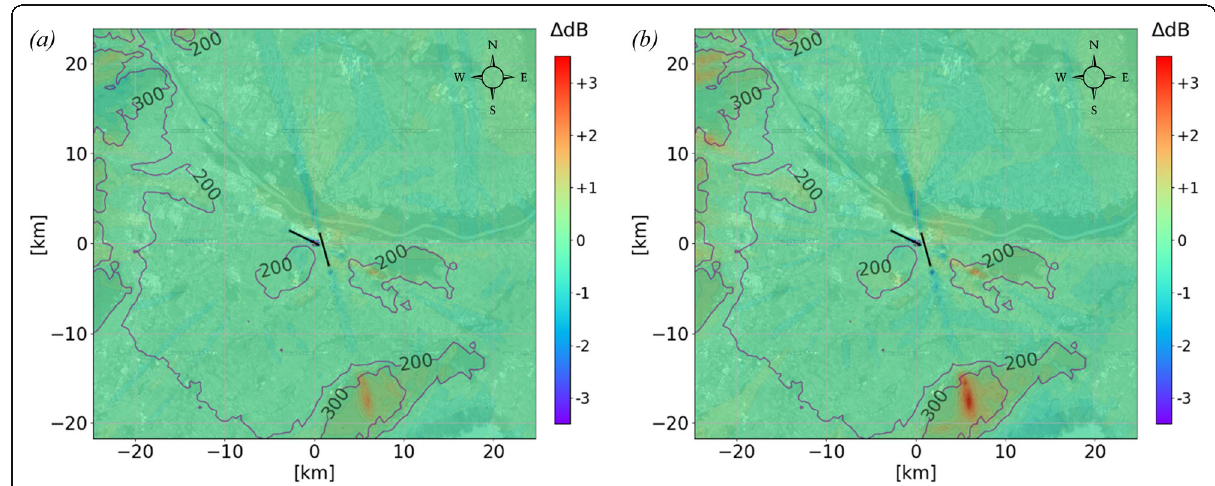
Fig. 9 Variations in L DEN (a) and L max,avg (b) at Vienna International Airport in 2018 due exclusively to the implementation of terrain elevation data, without fleet substitution ( Δ dB = level considering elevation – level considering flat terrain). The elevated regions (above 200 or 300 m) are enclosed by contour